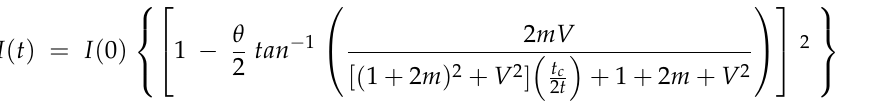
Figure 2. Schematic diagram of the mode-mismatched dual-beam TL setup.